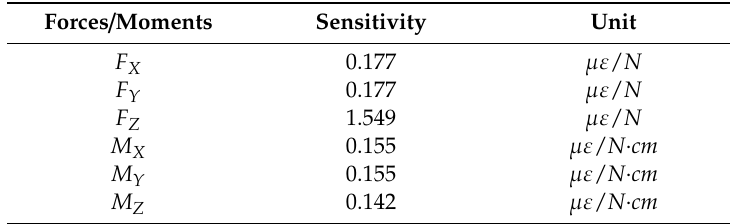
Table 1. Theoretical sensitivity of the elastic structural